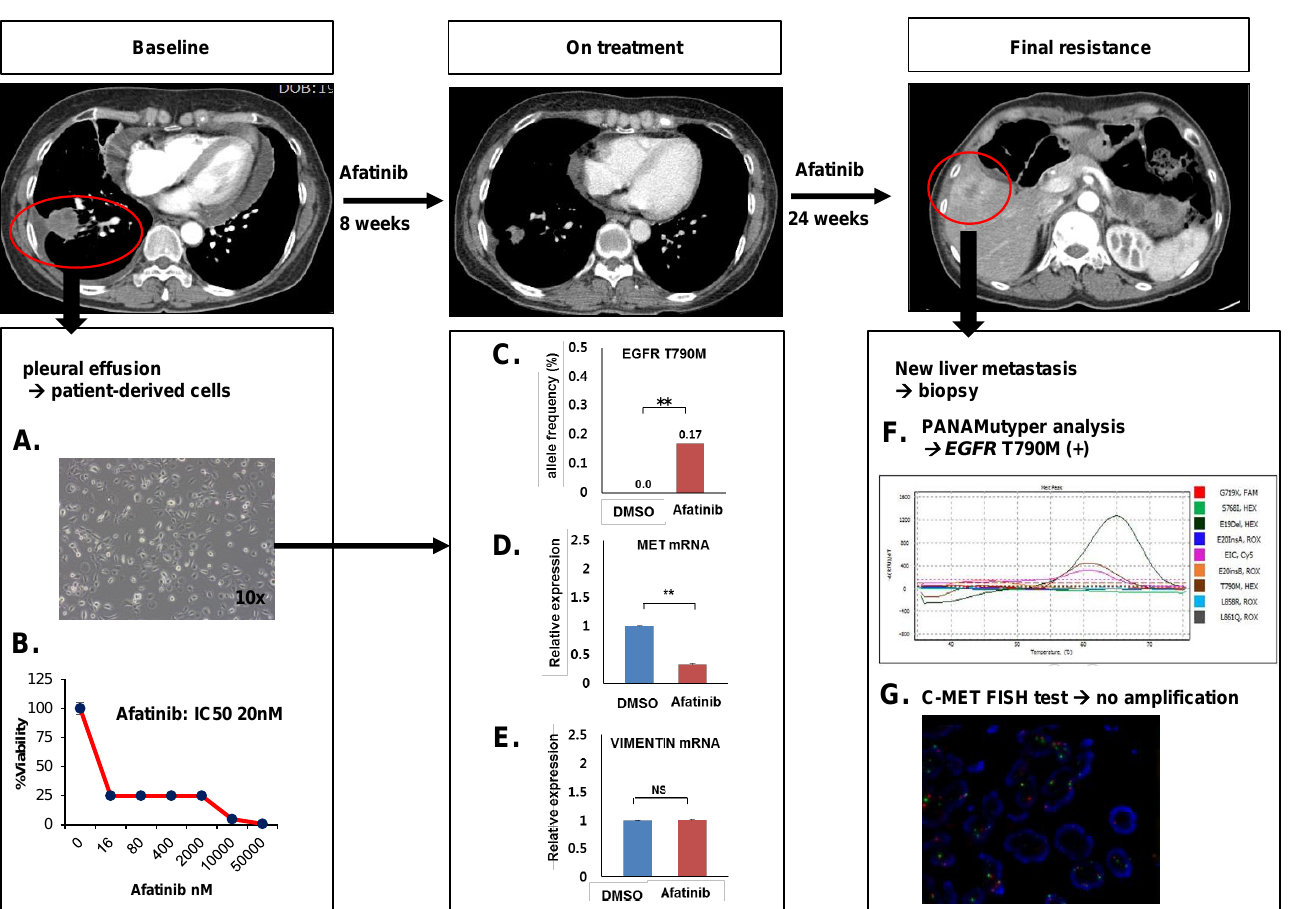
Figure 5. Prediction of resistant gene alteration using PDCs. ( A ) A PDC line (NCCLu-15) was established using pleural effusion from a treatment-naïve patient with lung cancer harboring an EGFR exon 19 deletion. ( B ) Sensitivity to the EGFR-TKI afatinib was tested using the MTS assay. ( C – E ) EGFR T790M mutations, C-EMT mRNA expression, and VIMENTIN mRNA expression were measured after 48 h of treatment with DMSO and afatinib (2 µ M) in the NCCLu-15. The allele frequency of EGFR T790M mutation was calculated by ddPCR. The C-MET and VIMENTIN mRNA levels were measured by RT-PCR. ( F , G ) EGFR T790M mutations and C-MET amplification were evaluated in post-treatment tumor tissue collected after the patient developed resistance to afatinib. EGFR mutations were tested using the PNA-Mediated Real-Time PCR Clamping Method (PANAMutyper), and C-MET amplification was assessed using fluorescence in situ hybridization. Error bars represent the mean ± SEM. Statistical analysis was performed using t -test. ** p ≤ 0.05; NS, not